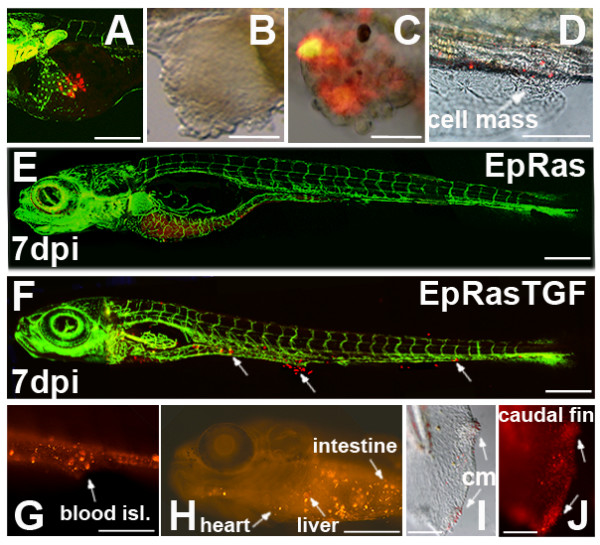
Migration and cell mass formation of Ha-Ras transformed mouse mammary epithelial cells injected into the yolk sac of zebrafish embryos. EpRas (parental) and EpRas cells stimulated with TGF-β (EpRasTGF) were labelled and ectopically injected into the yolk sac of 2 dpf zebrafish embryos. In A, E and F transgenic zebrafish embryos expressing GFP under an endothelial promotor (Tg(fli1:eGFP) were used. An example of newly injected EpRas cells at 1 hour post injection is given in (A). In (B) an ectopic tumour cell mass formed in the yolk sac by EpRasTGF cells is shown. Examples of cell masses formed by EpRasTGF cells at distance from the place of injection are shown for the tail region (C) and blood islands with surrounding ventral fin (D). Pictures in B-D were taken at 3 dpi. While EpRas cells remained in the yolk and never invaded the embryo (E), EpRasTGF cells invaded, migrated and formed distant micrometastases, which are indicated with arrows (F). Red fluorescence of cells is still visible after 7 dpi (E, F). Images G to J show tumour cell masses (cm) and migrated cells in blood islands (blood isl.), the liver, heart, intestine and the caudal fin of 6 dpi larvae. Scales shown are for A: 200 μm; D-H: 600 μm, for B, C, I and J: 100 μm. 3D reconstructions of EpRAS and EpRasTGF cells in zebrafish larvae are shown in two supplemental movies (see Additional file 2 and Additional file 3).